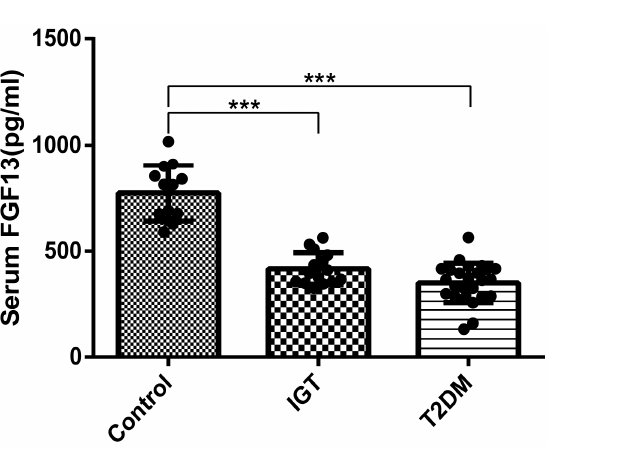
Figure 7. Comparison of serum FGF13 levels among IGT patients, T2DM patients, and control (*** p < 0.001 vs.